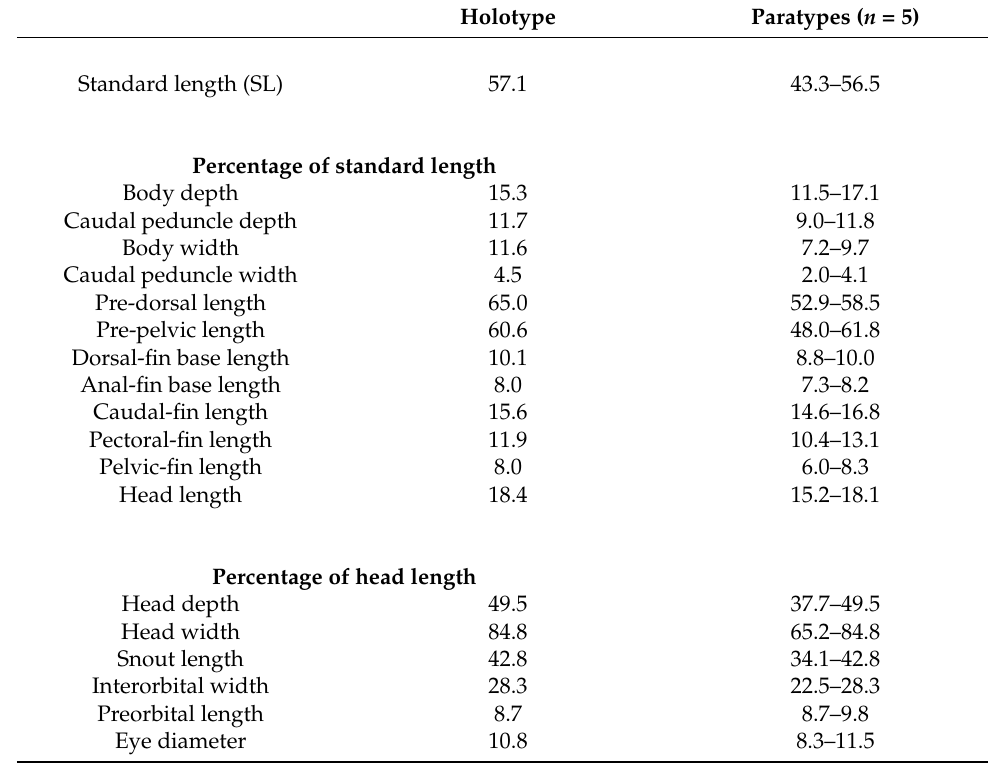
Table 5. Morphometric data of Trichomycterus adautoleitei Costa, Azevedo-Santos & Katz sp.